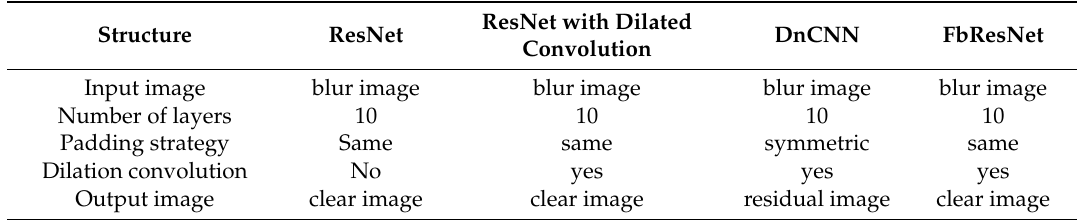
Figure 2. The architectures of the reformed ResNet and denoising convolutional neural network (DnCNN). ( a ) ResNet; ( b ) ResNet with dilated convolution; and ( c ) DnCNN. Table 1. Experiment setting of different